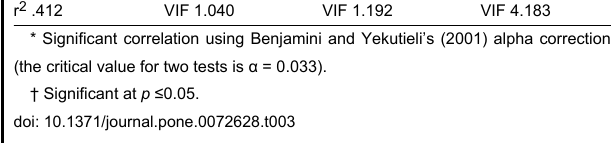
Figure 2. Scatter plot showing that total number of technounits (TTS) is influenced by population size in a sample of 40 small-scale food-producing groups. Both TTS and population size are logged.